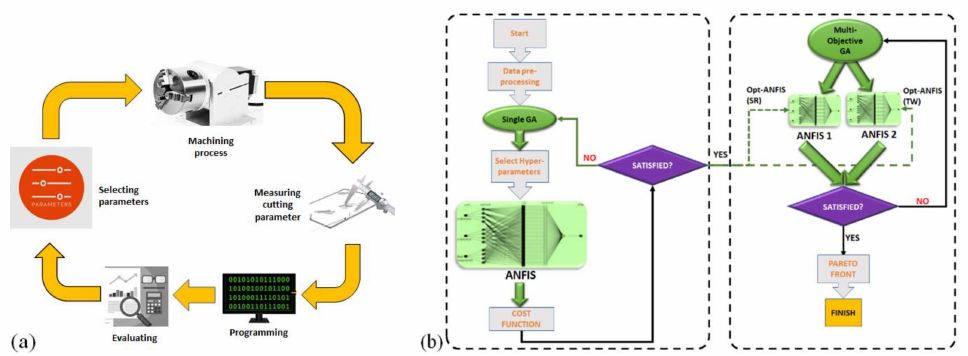
Figure 1. ( a ) The schematic structure of the whole proposed method; ( b ) the artificial intelligent section of this